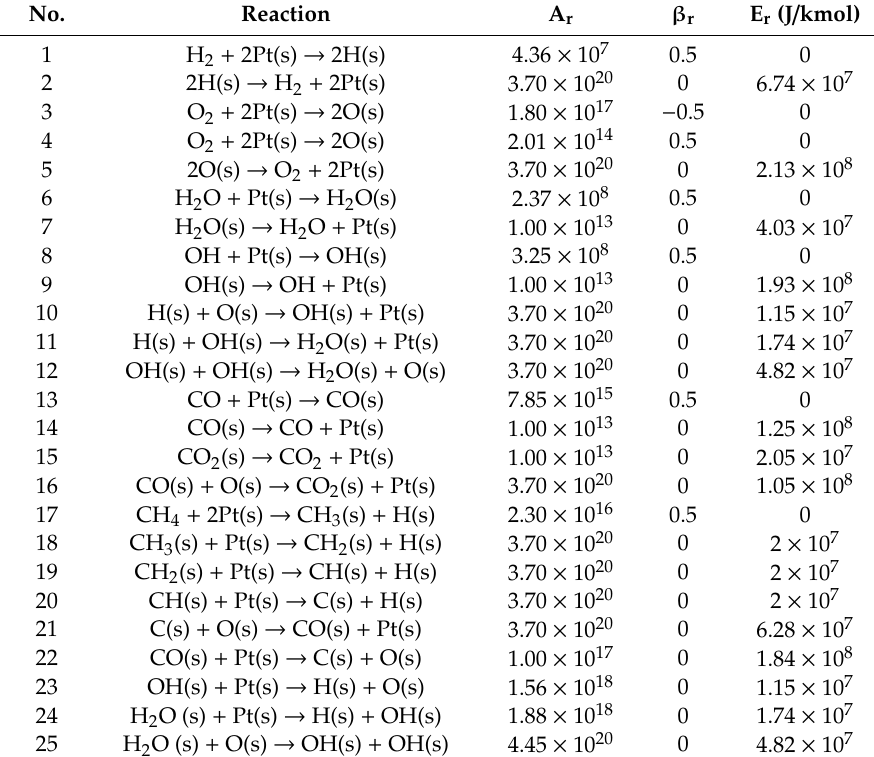
Table 4. VAM combustion surface reaction